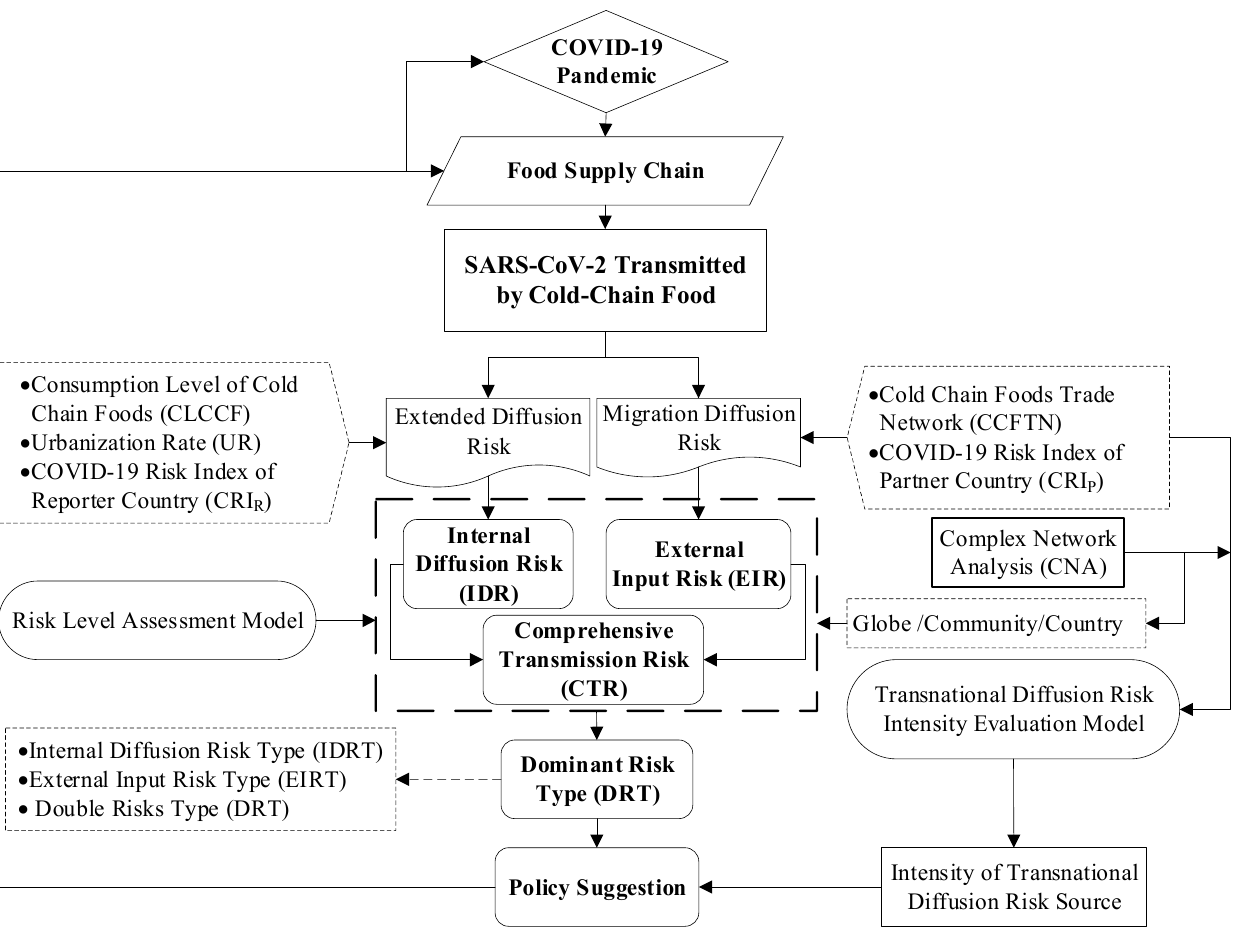
Figure 1. Study framework of COVID-19 transmission risk by CCF.